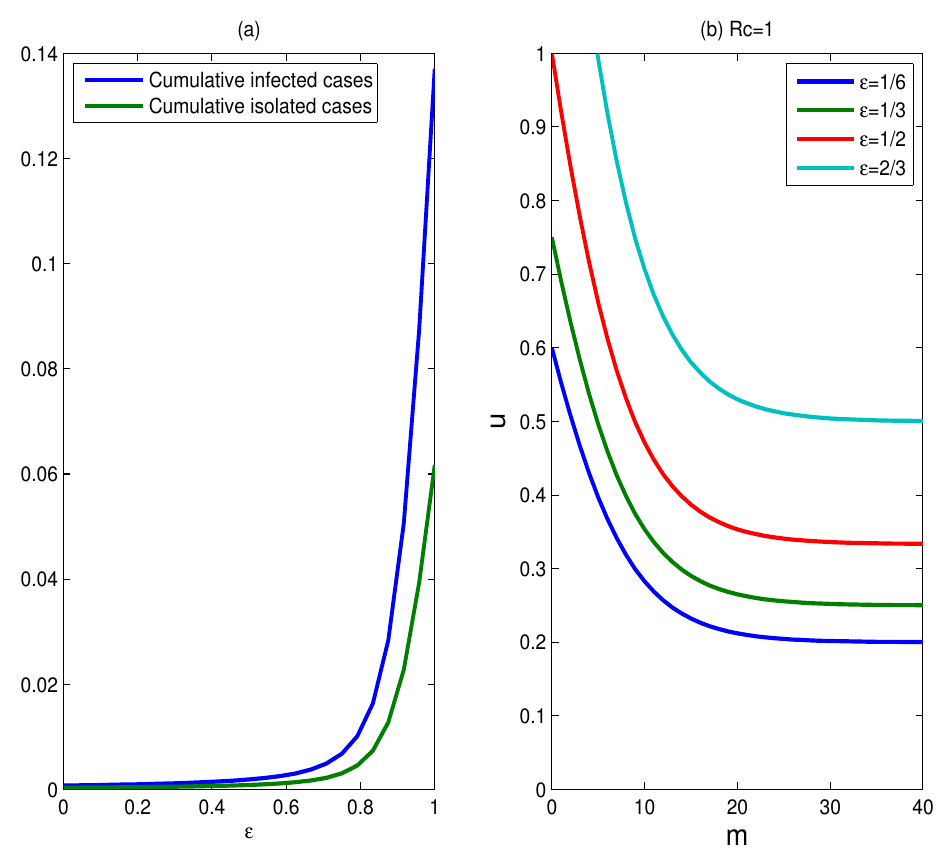
Figure 7. The effect of the infectivity reduction factor for isolated individuals. ( a ) Plots of the cumulative percentages of infected individuals and isolated cases as functions of (cid:15) ,